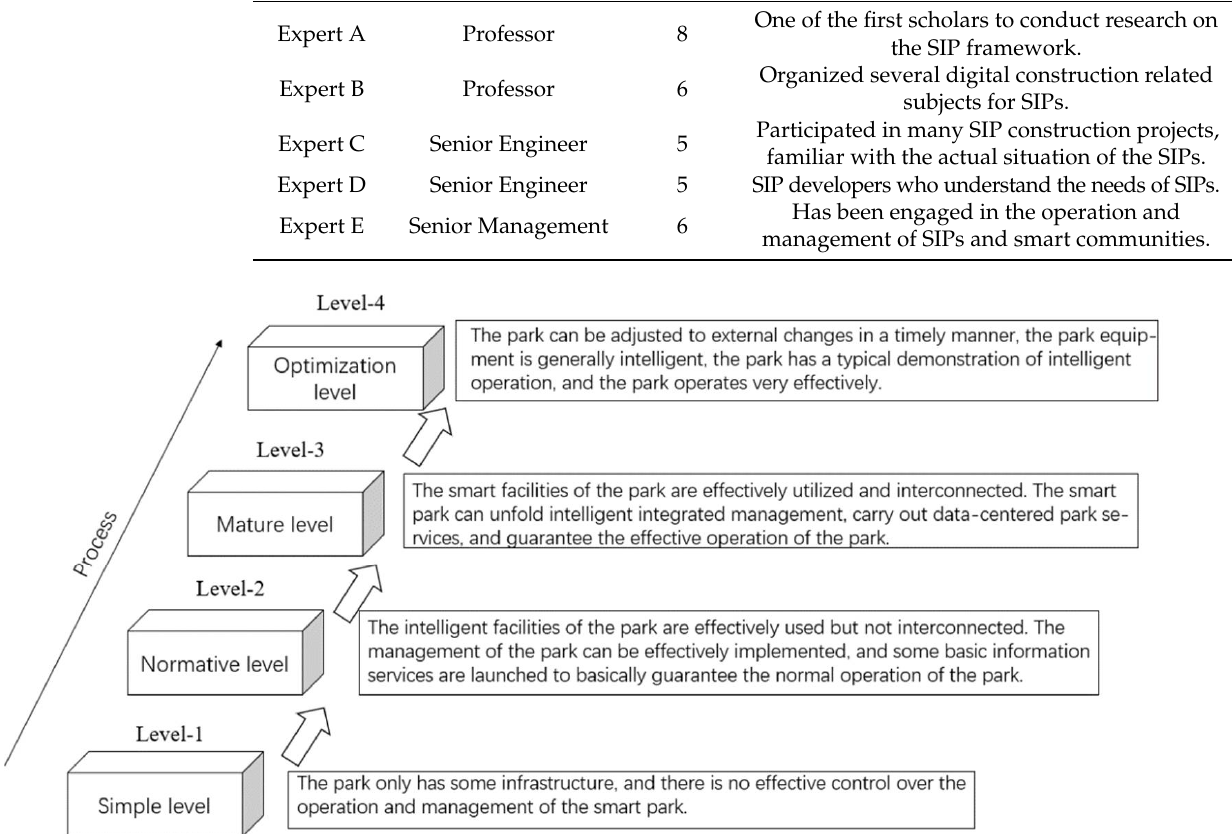
Figure 2. Smart industrial park intelligence level structure diagram.